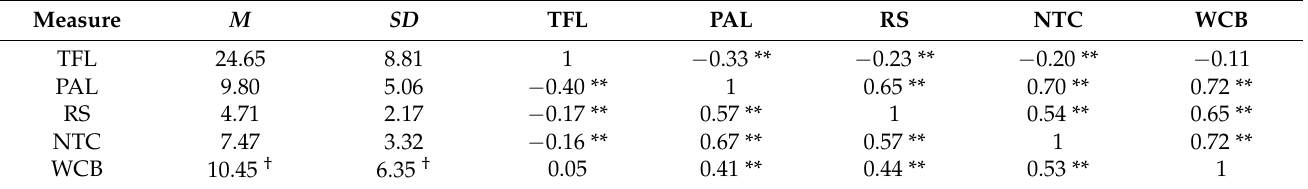
Table 1. Means, standard deviations and Pearson correlations between leadership, job demands and WCB for the German (n = 334) and Spanish (n = 249) sample.